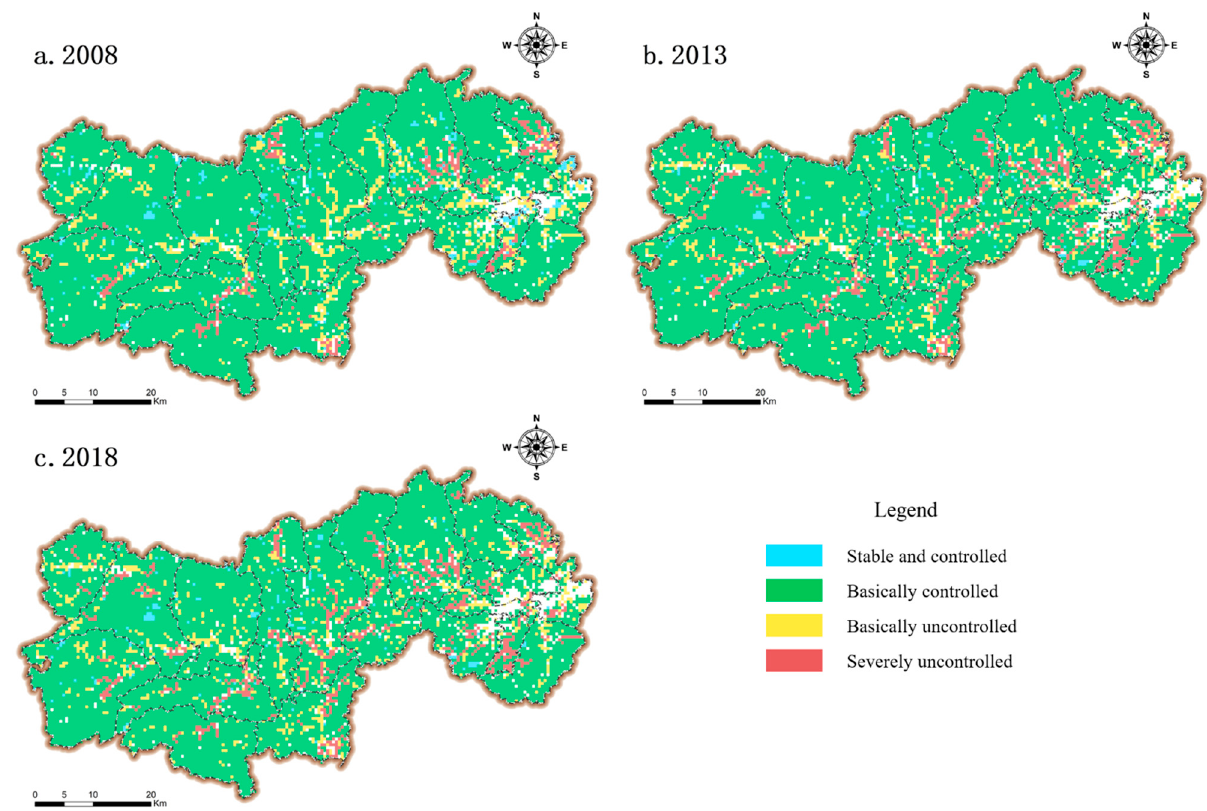
Figure 2. The degrees of land-use conflict between agricultural and ecological spaces in Lin’an District, 2008–2018. ( a ) 2008. ( b ) 2013. ( c ) 2018. Table 3. Changes in the global spatial autocorrelation of land-use conflict in Lin’an District,